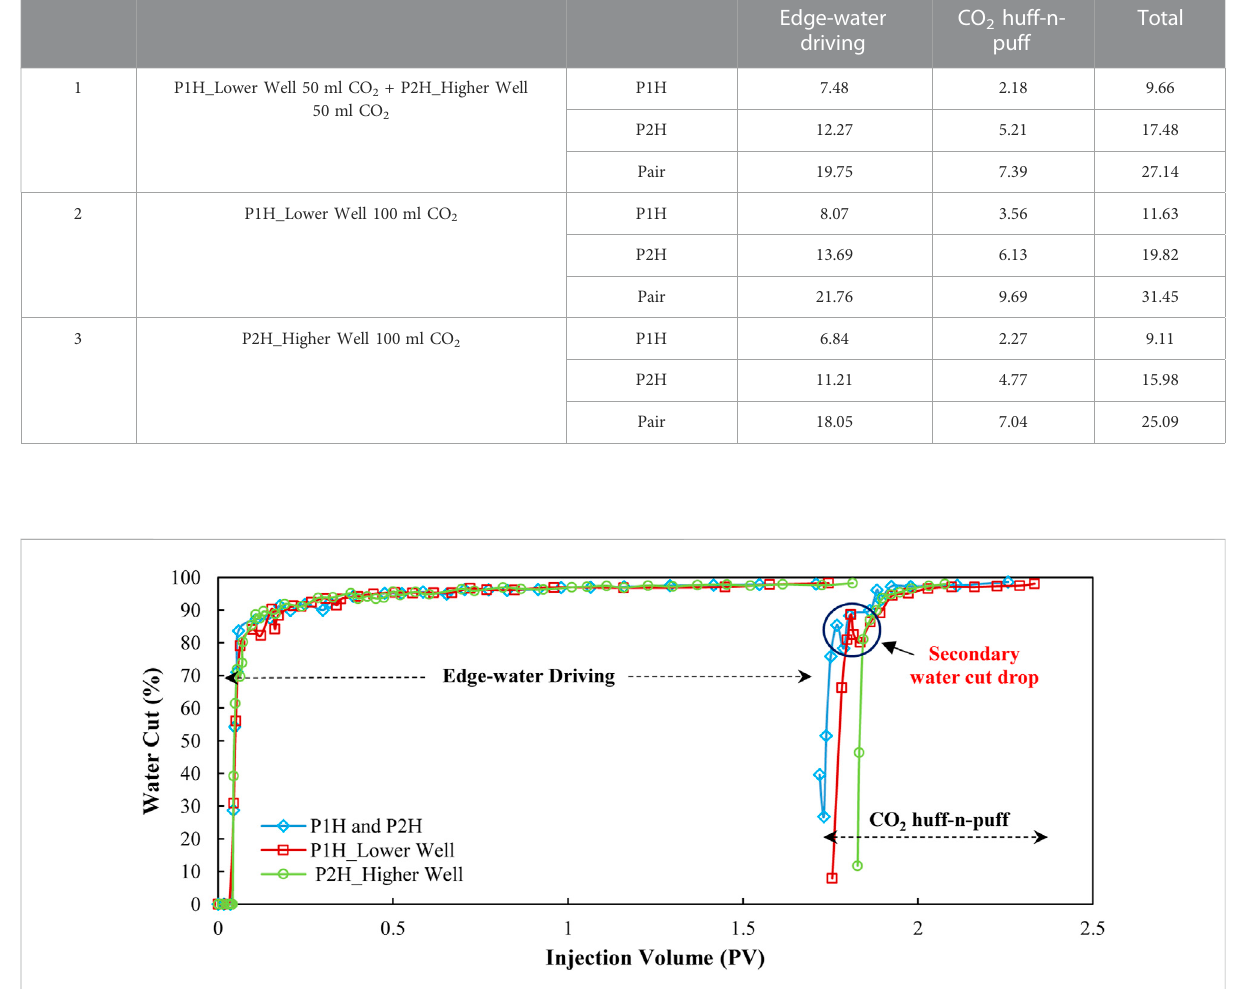
FIGURE 7 Comparison of composite water cuts for different CO 2 huff-n-puff